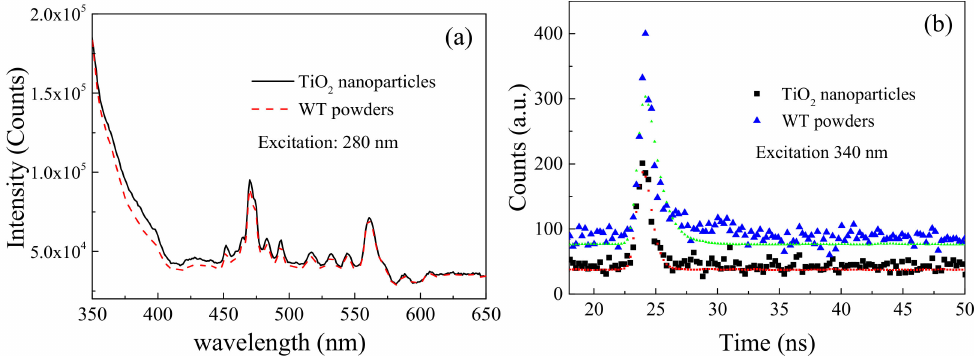
Figure 5. The ( a ) steady-state PL spectra and ( b ) time-resolved PL spectra of the WT powders and TiO 2